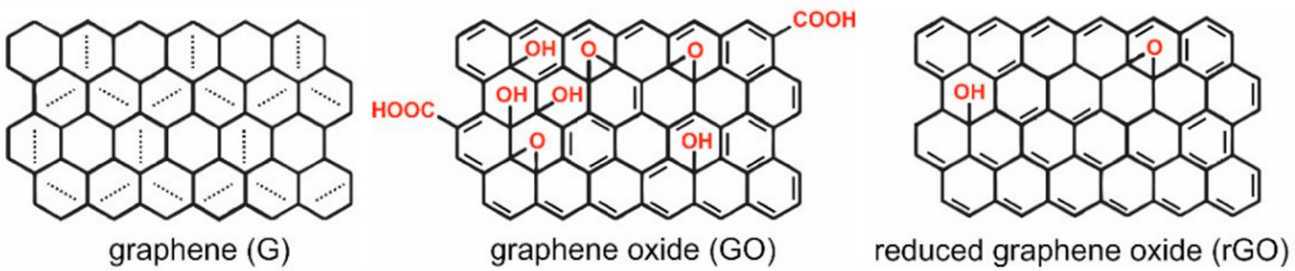
Figure 1. Graphical representation of the molecular structures of different graphene-based materials. Republished from Ref. [18].